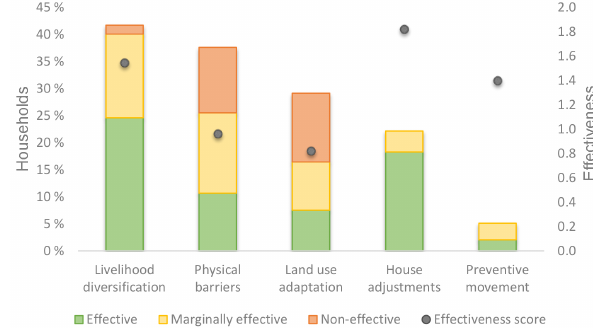
Figure 1. Uptake and effectiveness (effectiveness scores were cal- culated as “effective” · 2 + , “marginally effective” · 1 + and “non- effective” · 0.) of preventive